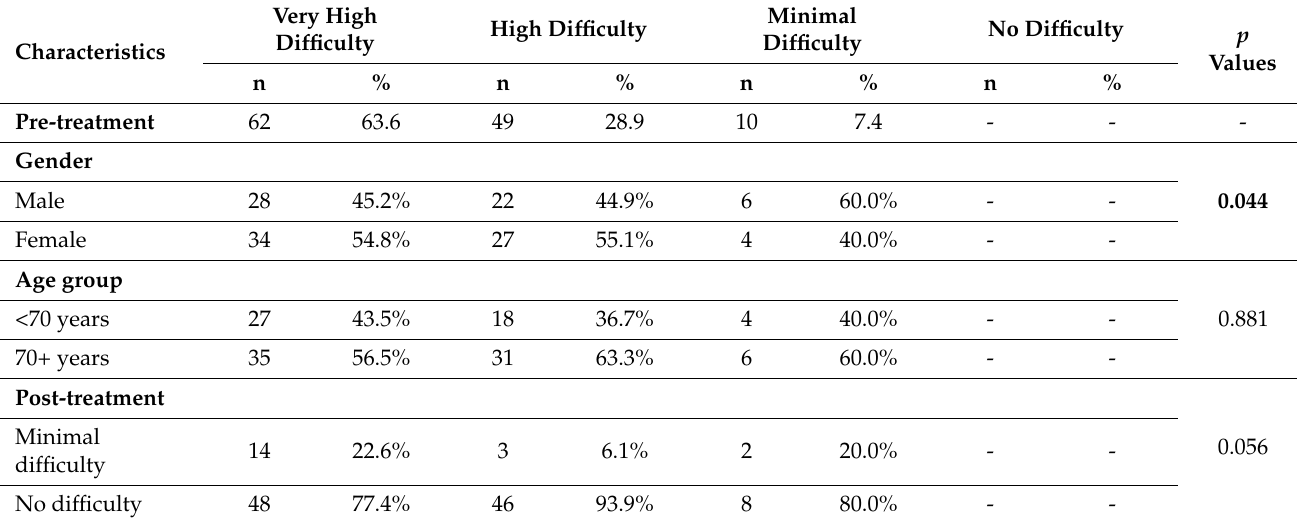
Table 9. The percentage distribution of patients with visual difficulties in daily activities according to pre- and post-treatment study group characteristics .